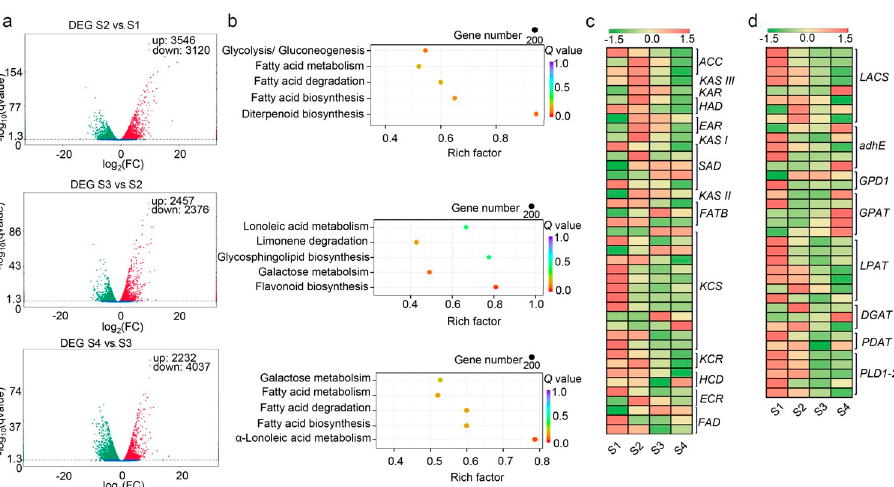
Figure 5. Identification and KEGG analysis of differentially expressed mRNAs (DEGs). ( a ) Identified DEGs in S2 vs. S1, S3 vs. S2, and S4 vs. S3. ( b ) KEGG pathway analysis of the DEGs in the context of FA and TAG biosynthesis. ( c ) Heatmap of the expression levels of DEGs in the FA biosynthesis